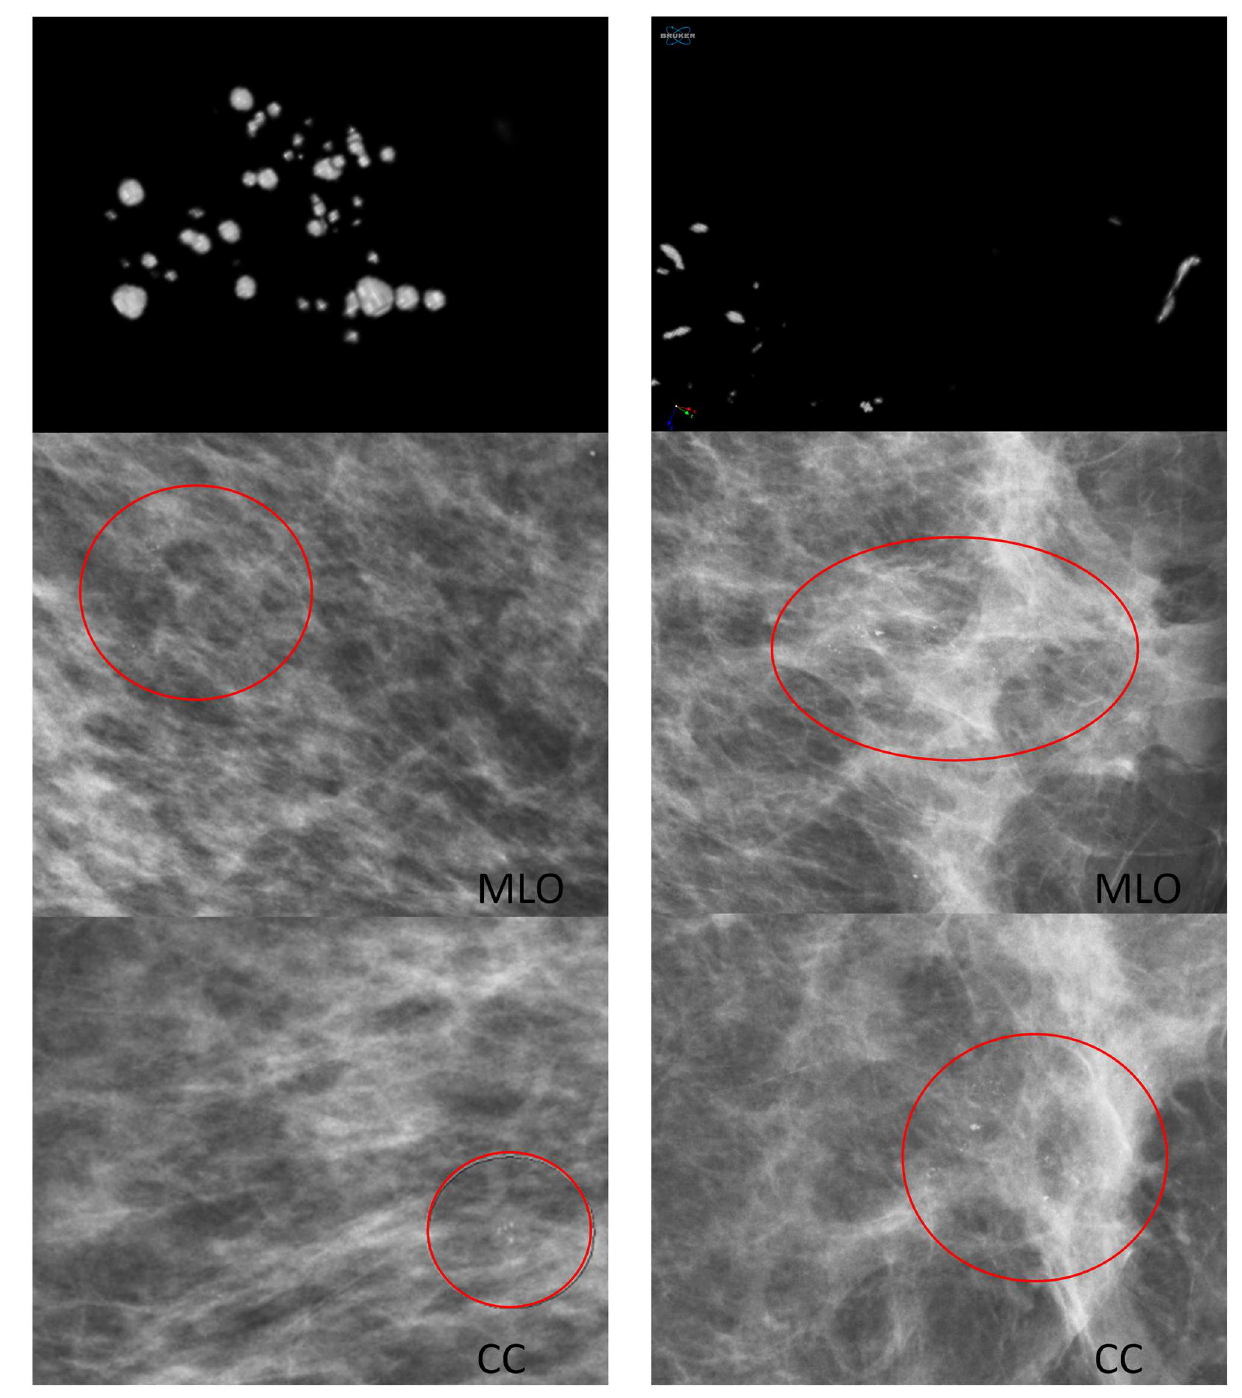
Fig 3. Representative 3D images and mammograms from two different patients. Left column: sample number 6 (fibrosis, sclerosing adenosis,normal ductal hyperplasia,intraductal papilloma),only sphericalMC classifiedas no suspiciousMC; right column:sample number 25 (DCIS high grade), fine linear MC. CC indicatescraniocranialcaudalview and MLO indicatesmediolateral obliqueview.